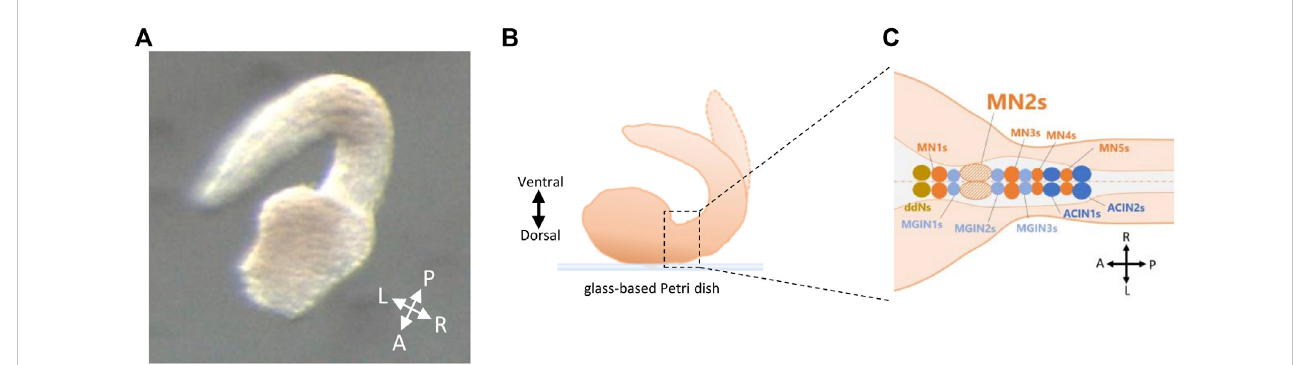
FIGURE 1 Fixation of Ciona embryos on glass-based Petri dish for MN2L and MN2R imaging. (A) Larvae fi xed on a glass-based Petri dish by its dorsal side (method used in this study). A, anterior; P, posterior; L, left; R, right. (B) Schematic illustration of a fi xed larva on a glass-based Petri dish by its dorsal side. (C) Neurons located inthe motor ganglion (MG) region of Ciona swimming larva seen from itsdorsalside. ddNs, descending decussatingneurons;MN1-5s, motor neuron 1-5s; MGIN1-3s, motor ganglion interneurons 1-3s; ACIN1-2s, ascending contralateral inhibitory neurons